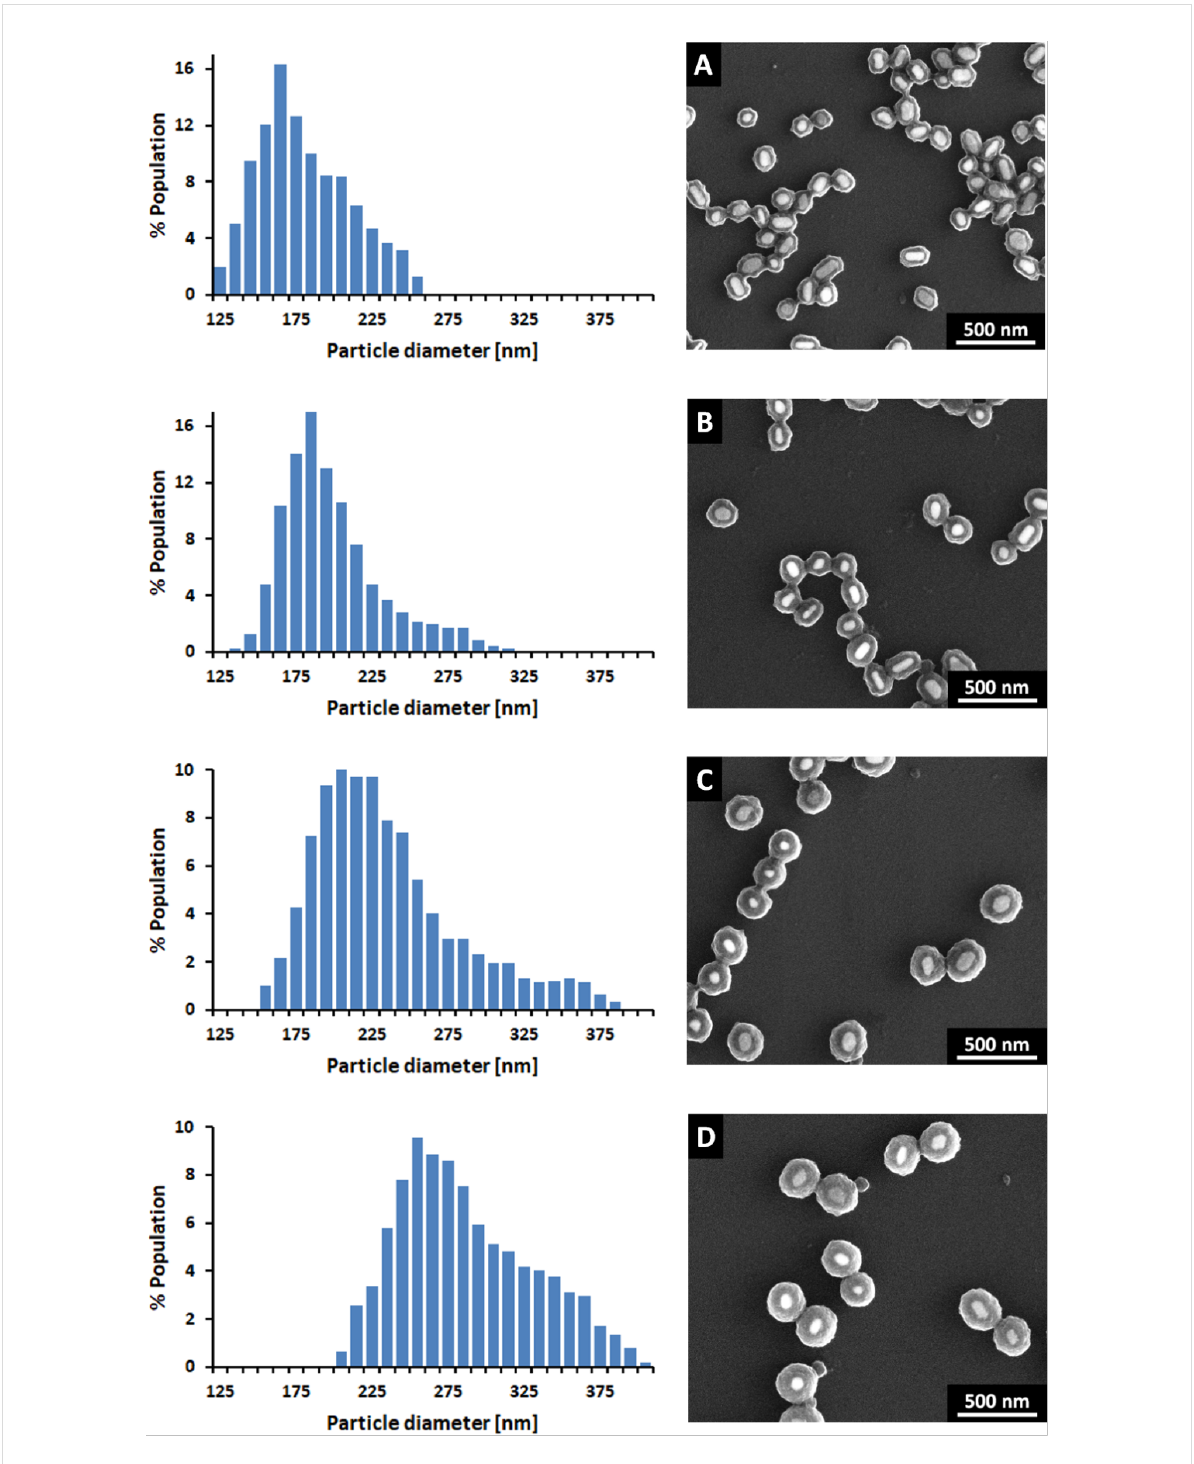
Figure 1: SEM images and TRPS size histograms of Au@TiO 2 (Samples A–D) structures with various titania shell thicknesses (see Table 1).